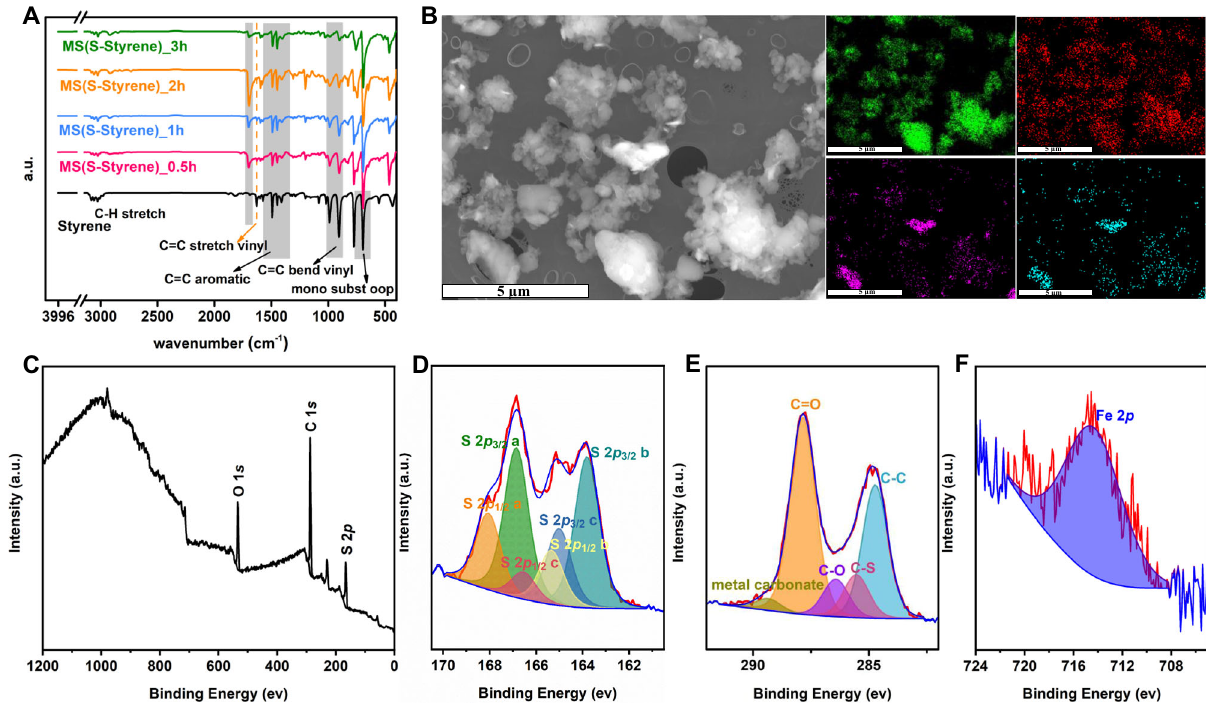
Fig. 2 | Structure and morphology characterizations. A Synthesis of MS(S-Styr- ene)monitored by using FT-IR. B SEM and EDS images (greeniselementalS,red is elementalC,purpleiselementalFe,andblueiselementalGr)ofproductMS(S-DIB)